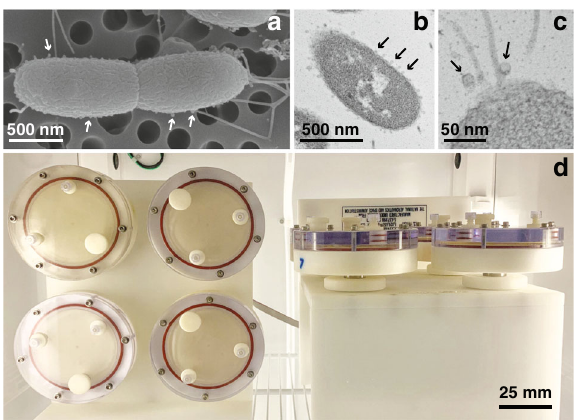
Fig. 1 Overview of the bene fi cial microbe Vibrio fi scheri morphol- ogy and experimental conditions. a Scanning electron micrograph of the wild-type V. fi scheri depicting the presence of outer- membrane vesicles (OMVs) on the cell surface (arrows). b Transmis- sion electron micrograph (TEM) of V. fi scheri during exponential growth producing numerous OMVs during exponential-phase growth. c Higher magni fi cation TEM visualizing OMVs associated with the bacteria fl agella. d Rotary cell culture system with high- aspect ratio vessels containing V. fi scheri cultures in the modeled microgravity (left) and gravity (right) control positions.